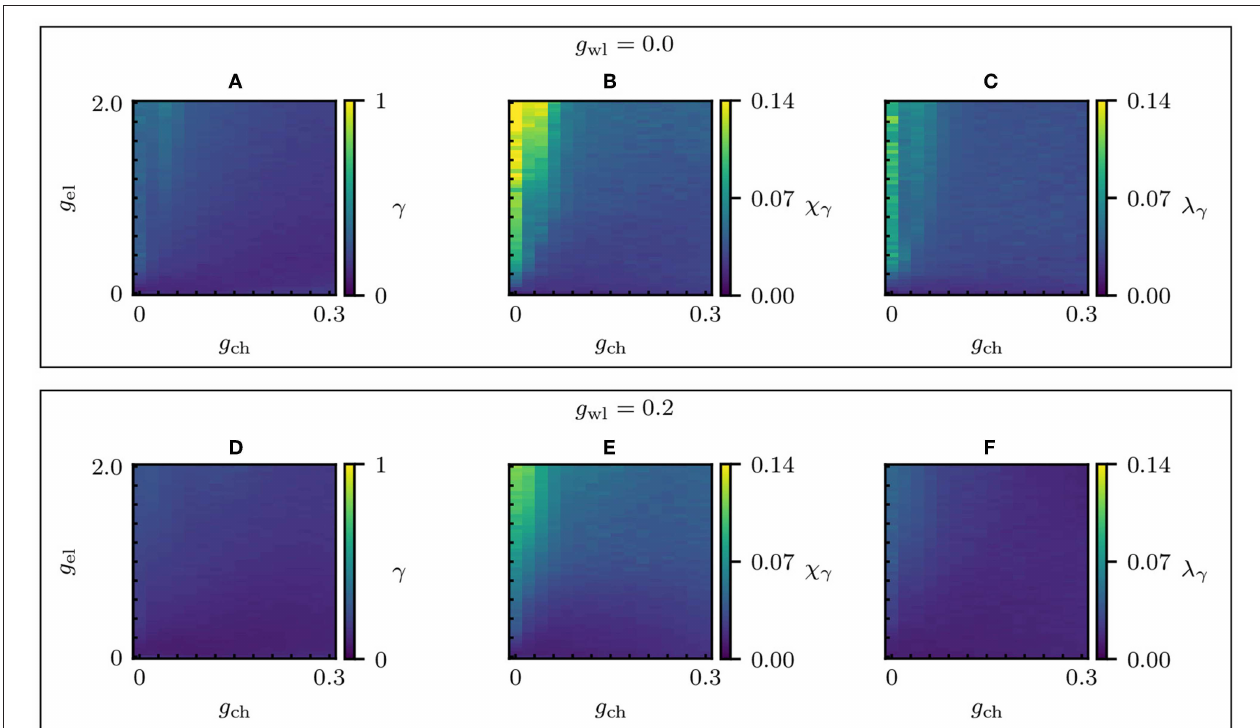
FIGURE 9 | Synchronization parameter scans of the dynamical correlation-based network. Changes in the global dynamical properties as the electric and chemical coupling strengths vary. (A–C) Absence of wireless coupling ( g wl = 0) for different electrical and chemical couplings: the global level of synchronization of the whole network γ , the chimera-like index χ γ and the metastability index λ γ . (D–F) γ , χ γ , and λ γ for g wl = 0.2. The system parameters are the same as in Figure 3 , except for g wl . Refer to Figures S3, S4 for the parameter scans including γ i